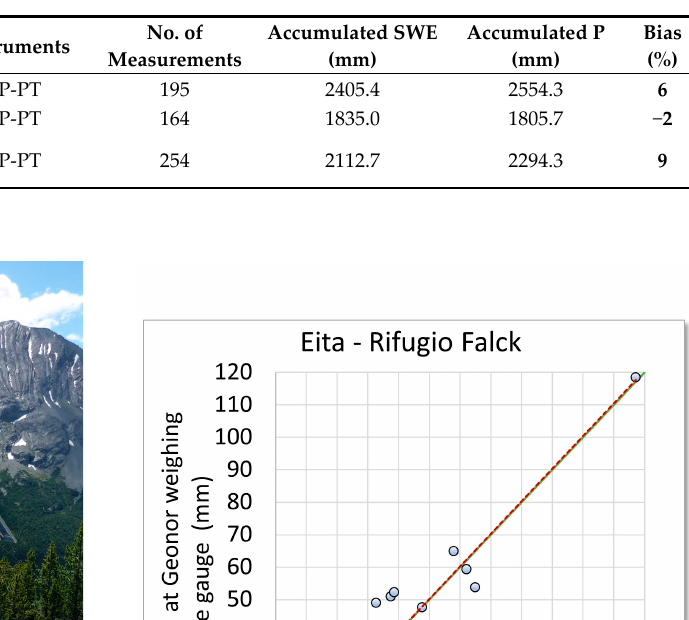
Table 2. Comparison between melted snow measured by Geonor weighing storage gauge with Alter windshield (PT) and SWE of fresh fallen snow measured by snow pillows (SP) installed in new A2A monitoring sites.